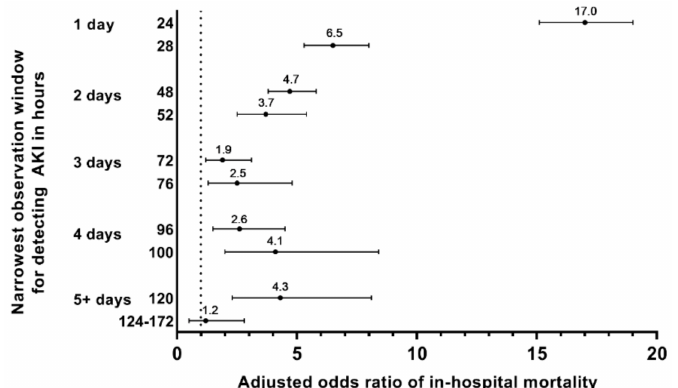
Figure 8. Adjusted odds ratio of in-hospital mortality by narrowest observation window for de- tecting AKI ( n = 126,367). AKI, acute kidney injury. Adjusted odds ratios (dots) and 95% confidence intervals (lines) were calculated using logistic regression, where the reference category were pa- tients who did not develop AKI. Logistic regression was adjusted for hospital admission status (elective/unknown, urgent, and emergency), estimated GFR in categories of 15 mL/min/1.73 m 2 based on first hospital serum creatinine, gender, hospital type (academic medical center vs. commu- nity hospital), and baseline comorbidities of diabetes, anemia, hypertension, congestive heart failure, liver disease, and peripheral and visceral